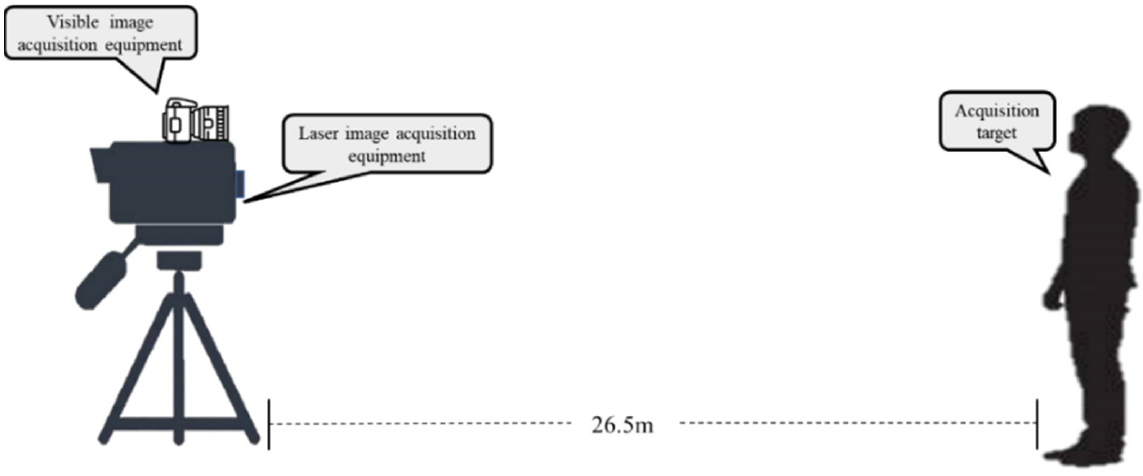
Figure 2. Schematic diagram of the image acquisition scene.